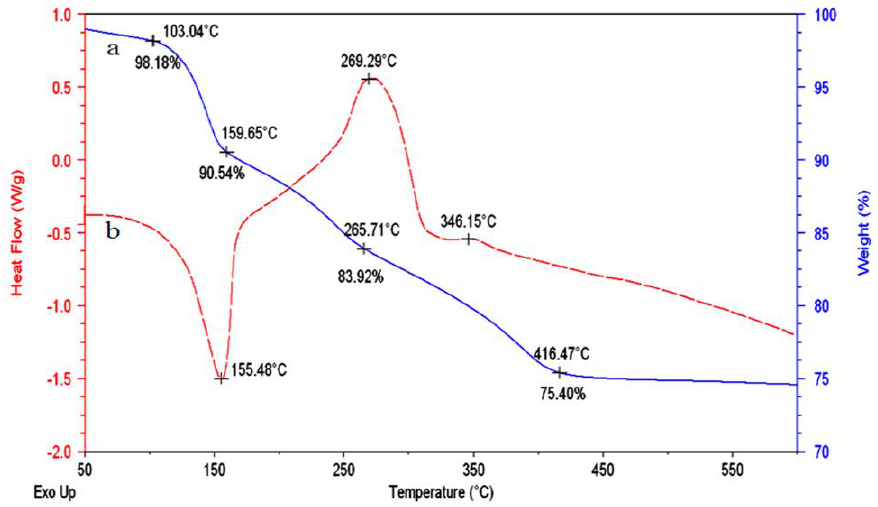
Figure 4. Thermal analyses (TG and DSC) of the CoFe 2 O 4 -supported Co-Fe LDH.